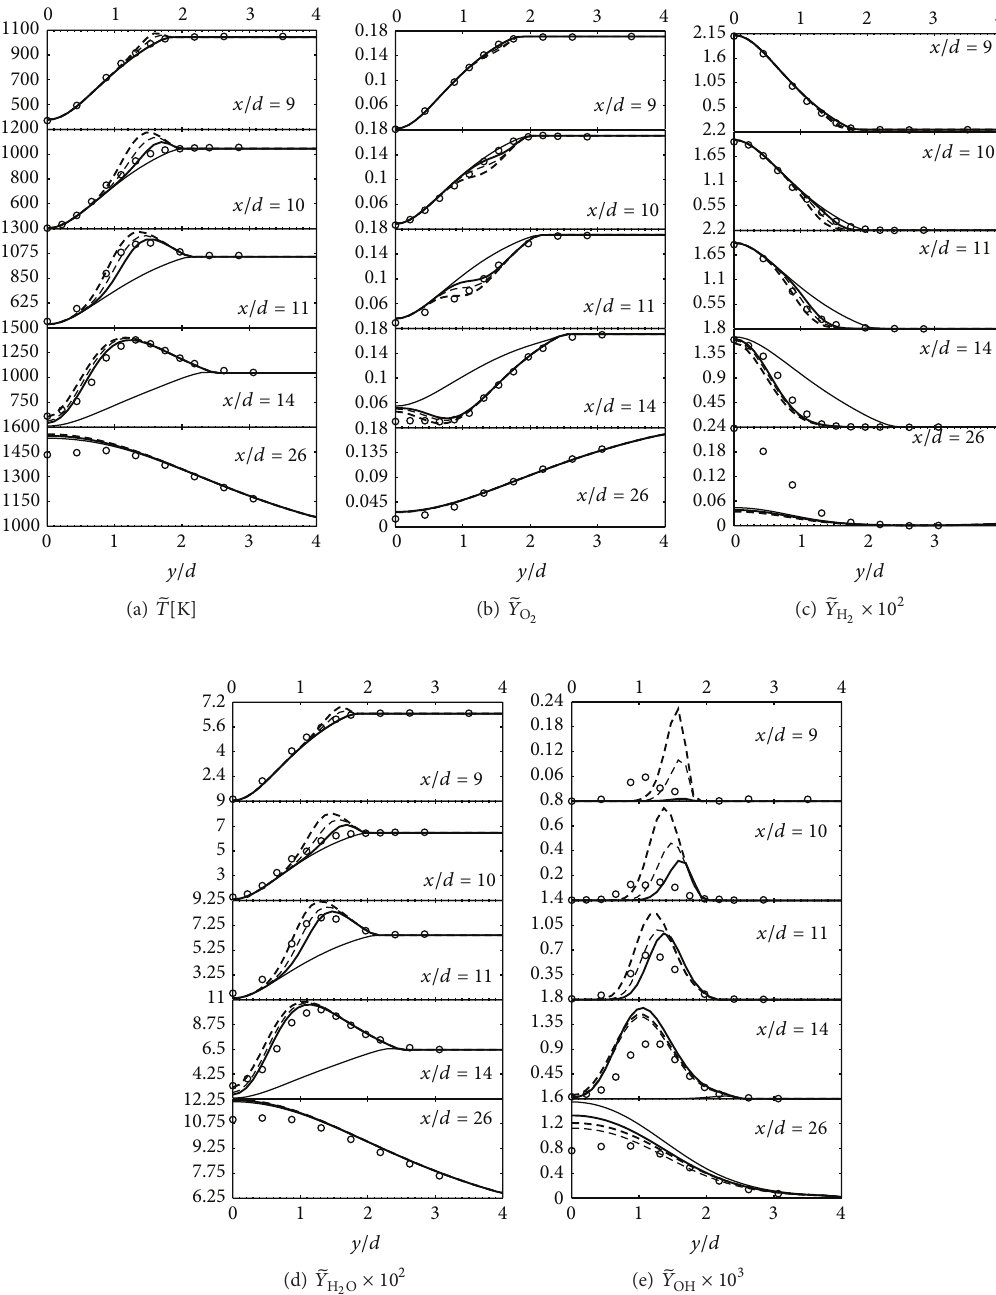
̃𝑇 ̃𝑌 ̃𝑌 (×10 2 ) , (d) ̃𝑌 (×10 2 ) , and (e) ̃𝑌 (×10 3 ) using different chemical kinetic mechanisms. , (b) , (c) O 2 H 2 H 2 O OH